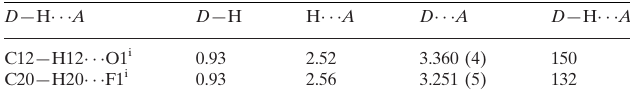
Data collection Bruker SMART APEX area- detector diffractometer Absorption correction: multi-scan ( SADABS ; Sheldrick, 1996)